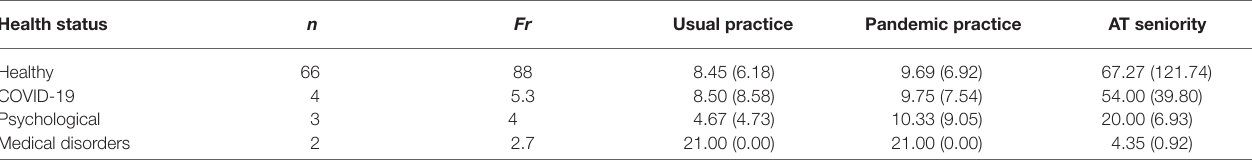
TABLE 1 | AT patterns of practice and AT seniority by health